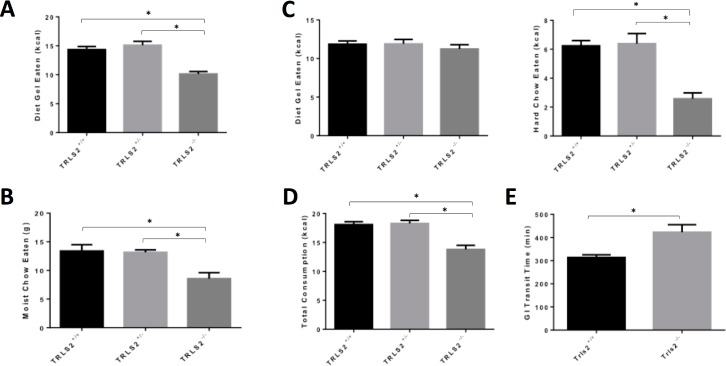
TRLS2-/- mice feed less and have slow GI tract motility.A)
Trls2+/+, Trls2+/-, and Trls2-/- mice were given diet gel and water, and the amount of diet gel eaten was tracked during three consecutive 24 hour periods. The average amount of diet gel eaten by Trls2-/- mice was significantly less than Trls2+/+ and Trls2+/- mice (One-Way ANOVA. F(2,28) = 22.61, p < 0.0001. Tukey’s Post Hoc Test p < 0.05). B)
Trls2-/- mice eat less moist chow (One-Way ANOVA. F(2,20) = 8.749, p < 0.01. Tukey’s Post Hoc Test p < 0.05). C) When given a choice between diet gel and intact chow, Trls2-/- mice eat similar amounts of diet gel to Trls2+/+ and Trls2+/- mice but eat significantly less hard chow (One-Way ANOVA. F(2,21) = 16.93, p < 0.0001. Tukey’s Post Hoc Test p < 0.05). D) The total kcal consumed was calculated by adding the amount of hard chow and diet gel eaten, and Trls2-/- mice ate significantly less than Trls2+/+ and Trls2+/- mice (One-Way ANOVA. F(2,27) = 18.20, p < 0.0001. Tukey’s Post Hoc Test p < 0.05). E) Mice were gavaged with a red methylcellulose gel and the time for red feces to appear was noted for each mouse. Trls2-/- had much slower transit times than Trls2+/+ mice (Student’s T-Test. t23 = 3.631, p < 0.01). Significance (p < 0.05) is denoted with an *, and error bars represent Standard Error of the Mean. (n+/+ = 9–15, n+/- = 8–13, n-/- = 7–10).